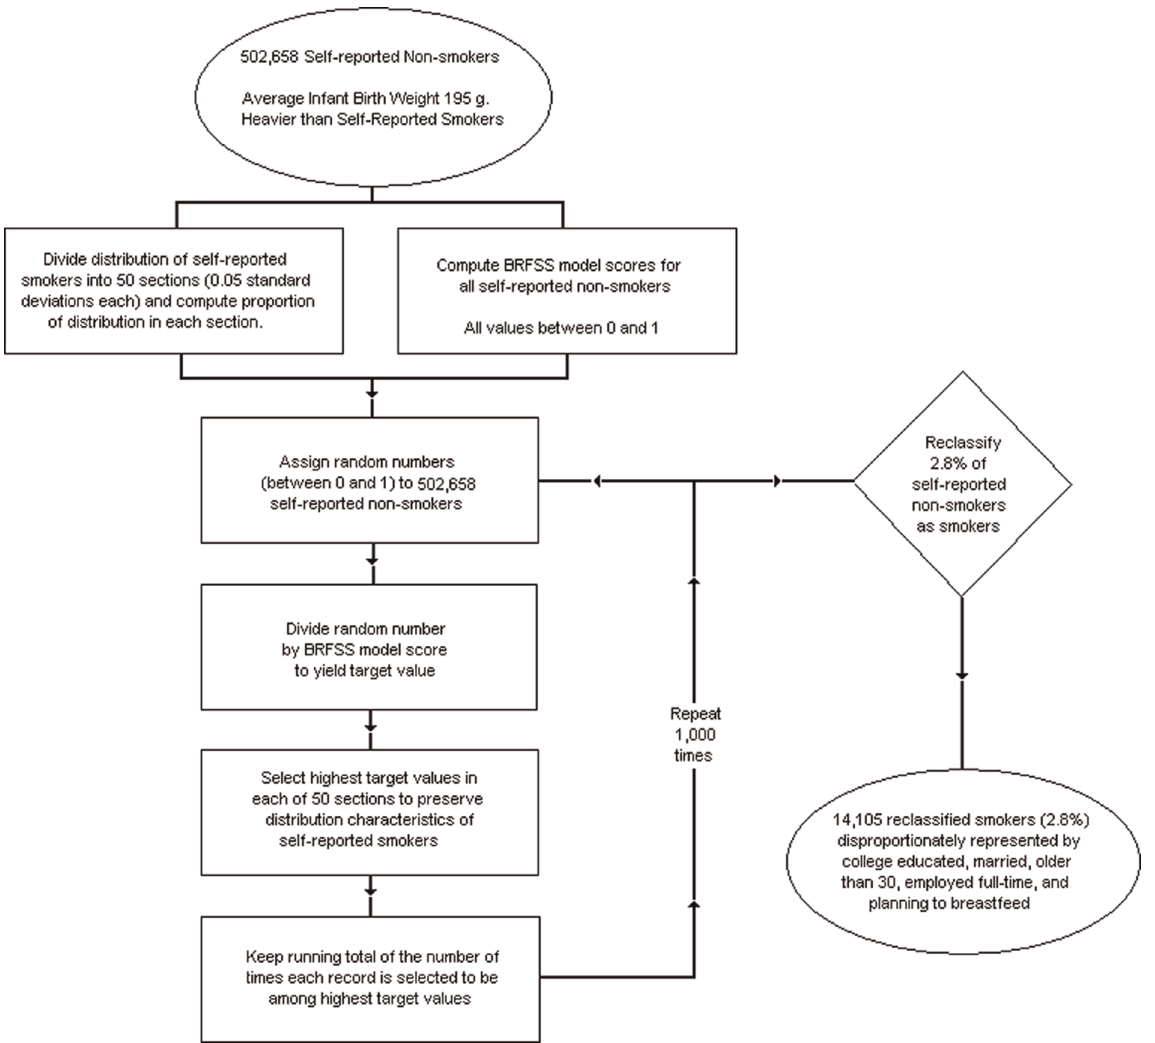
Figure 2. Flow chart of Monte Carlo procedure for reclassifying non-smokers as smokers.